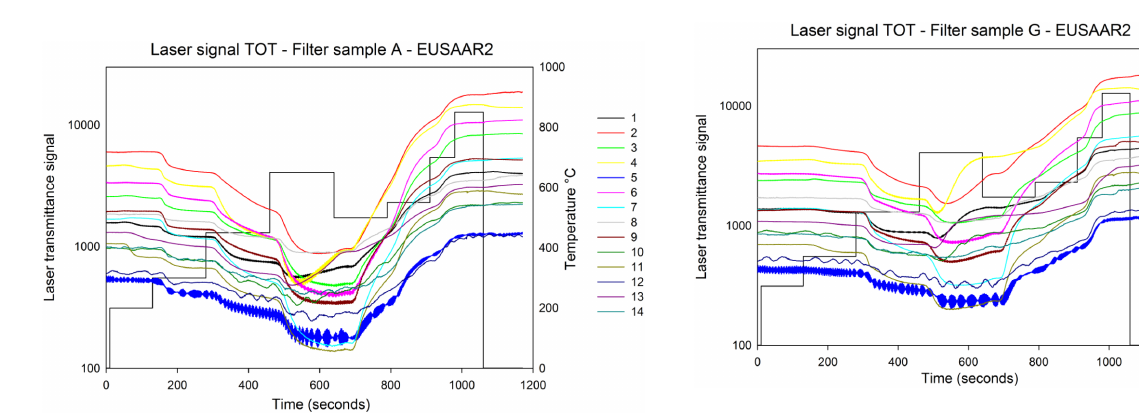
Figure 8. OC, POC and EC (TOT) concentrations (µg10µL − 1 ) per temperature step and protocol for sucrose solution (S2).